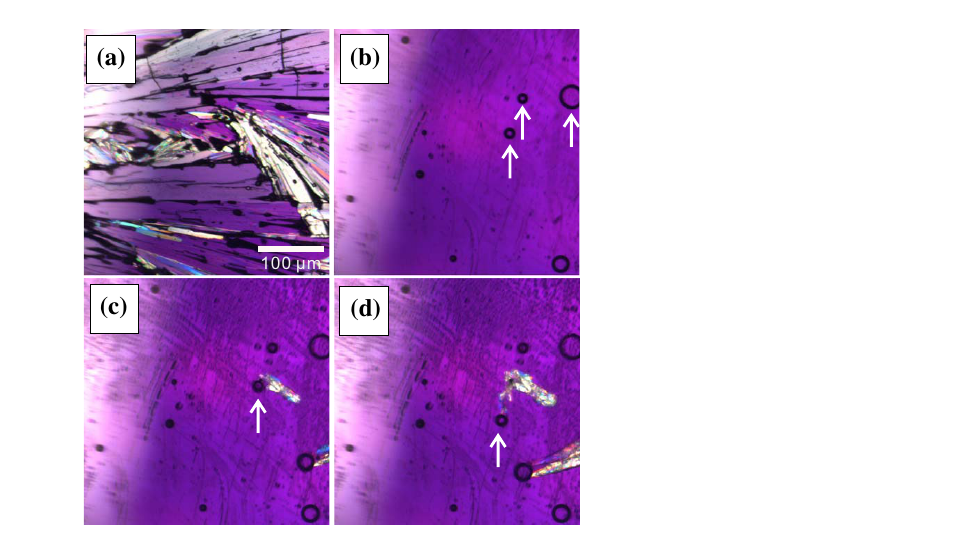
Figure 4. ( a ) A snapshot of a crystal. ( b ) The crystal was heated above the melting temperature and then the crystal was melted . The emerged bubbles remain indicated as arrows. Then, the liquid was quenched at 283 K. A crystal was nucleated and grew with time. ( c ) A snapshot just before the crystal was contacted with the remained bubble ( t = 7.2s ). ( d ) A filamentous growth was observed after the crystal was contacted with the remained bubble ( t = 8.3s